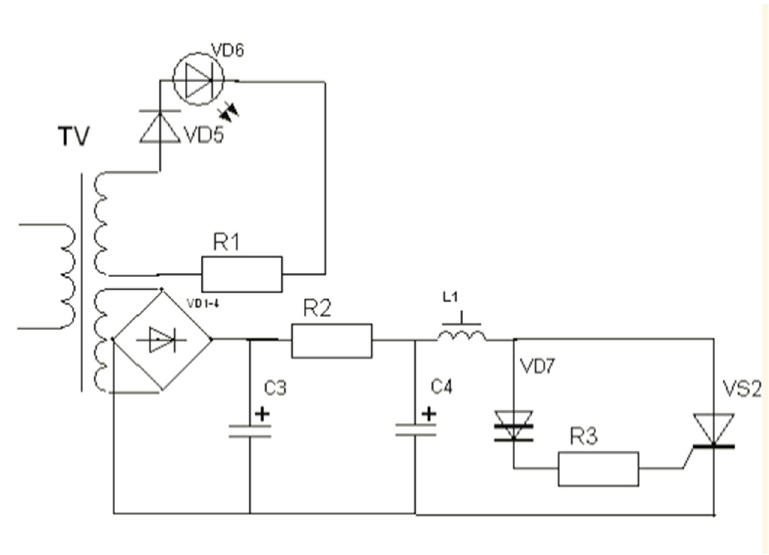
Figure 4. Diagram of the pulse converter of the electric pulse heater: TV —amplification unit, VD1 —rectifier matrix, C4 —capacitive storage, VD7 —dinistor, VS2 —thyristor, L1 —heater winding, [own elaboration].